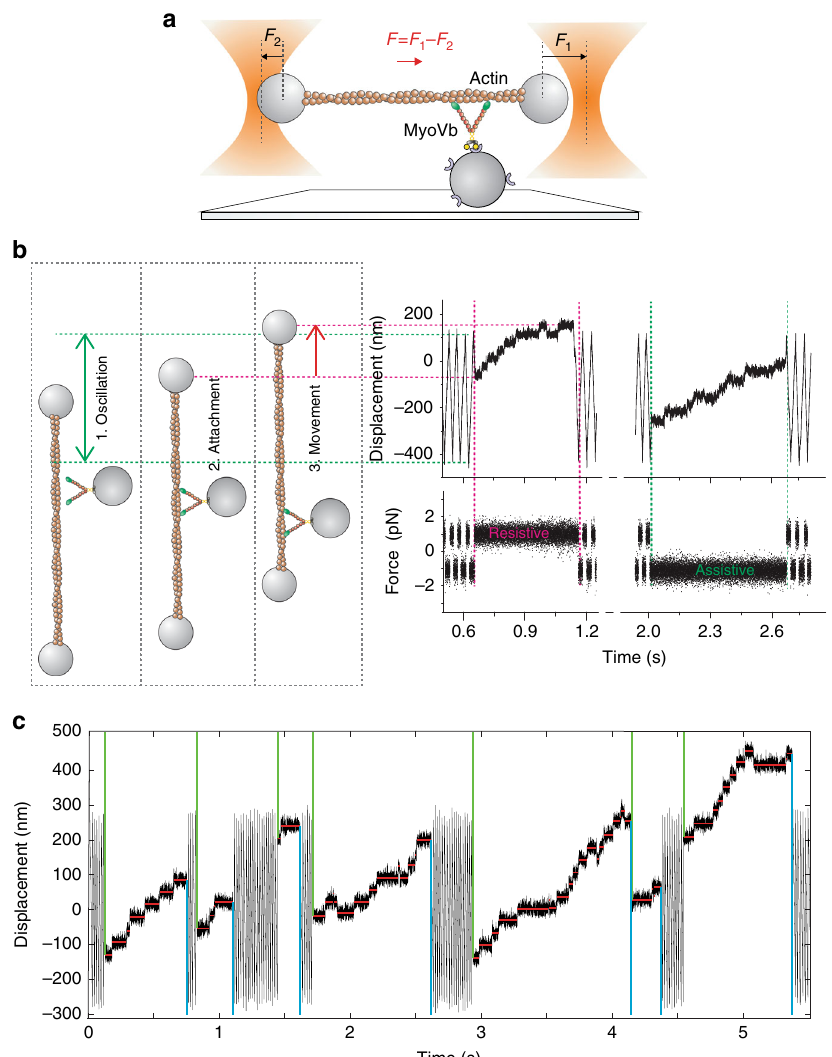
Fig. 3 Load dependence of myosin-5B stepping signatures investigated with high-speed optical tweezers. a Schematic of ultrafast force-clamp spectroscopy applied to a processive myosin-5B motor. A single myosin-5B molecule is attached to a glass bead pedestal through a streptavidin-biotin link. A single actin fi lament is trapped by suspending it between alpha-actinin coated beads. Black arrows represent the force clamped on the right ( F 1 ) and left bead ( F 2 ), red arrow represents the net force ( F ) on the dumbbell. F is alternated back and forth to maintain the dumbbell within a limited oscillation range when myosin is not bound to actin. b Left: cartoon showing the position of the right bead when: (1) myosin is unbound and the dumbbell oscillates; (2) myosin attaches to actin; and (3) myosin moves towards the actin barbed end. Right: example trace showing displacement and force during the corresponding phases of dumbbell oscillation, myosin-5B attachment, and processive runs under assistive and resistive loads. c Position record showing myosin-5B processive runs and the step and run detection algorithm. Detected beginning and end of each run are indicated by green and cyan vertical lines, respectively. Red horizontal lines indicate the detected steps. [ATP] = 100 μ